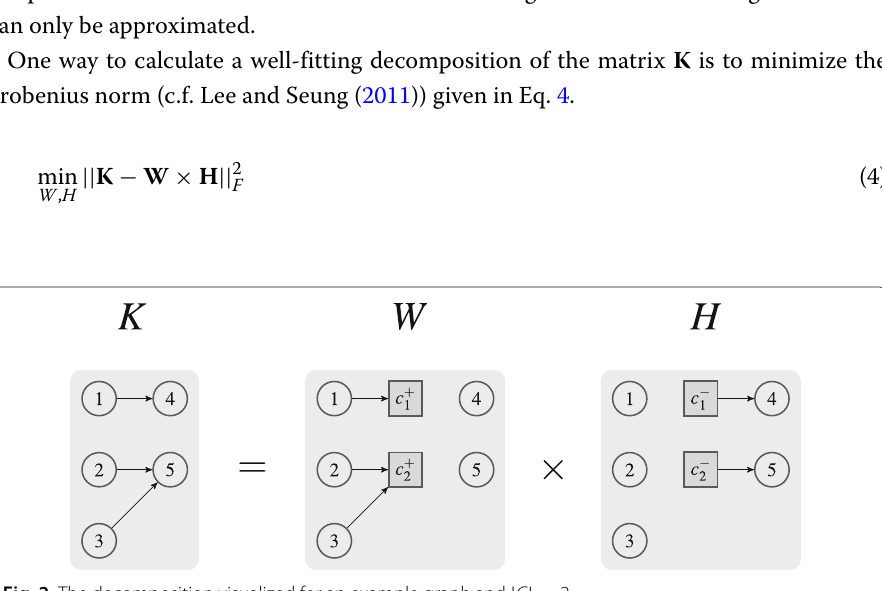
Fig. 2 The decomposition visualized for an example graph and | C | =